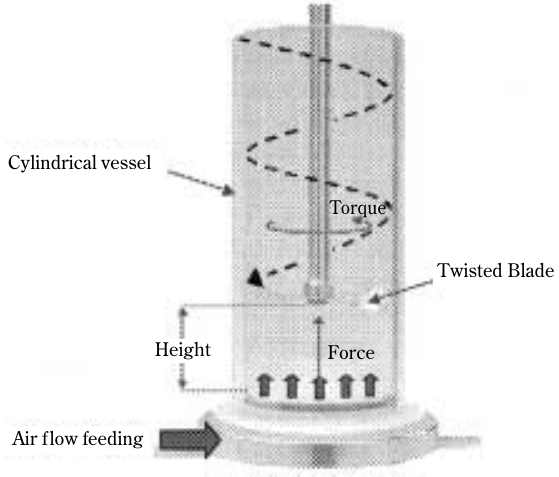
Fig. 3 Schematic diagram of FT4 powder rheometer from Freeman Technology